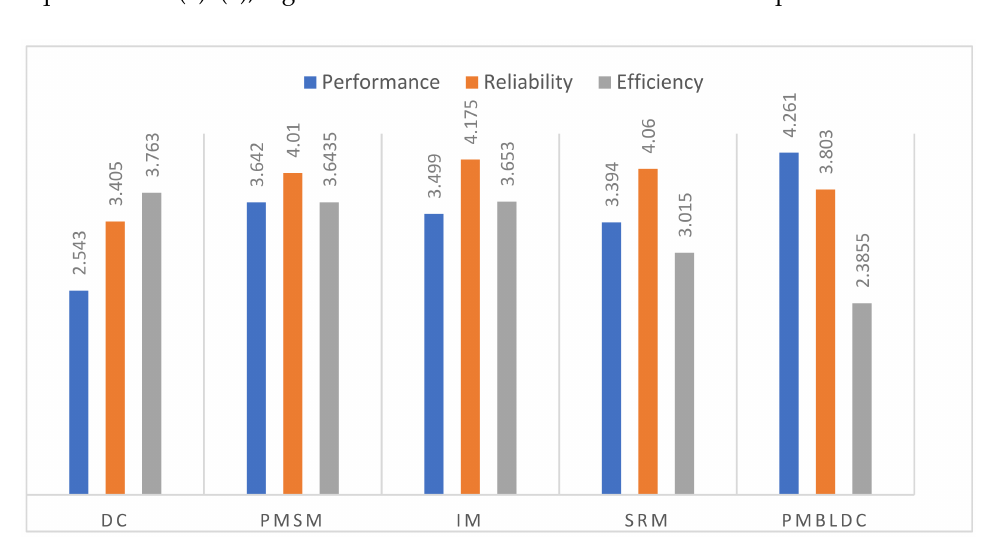
Figure 18. Factors related to the efficiency of electric motors for electric